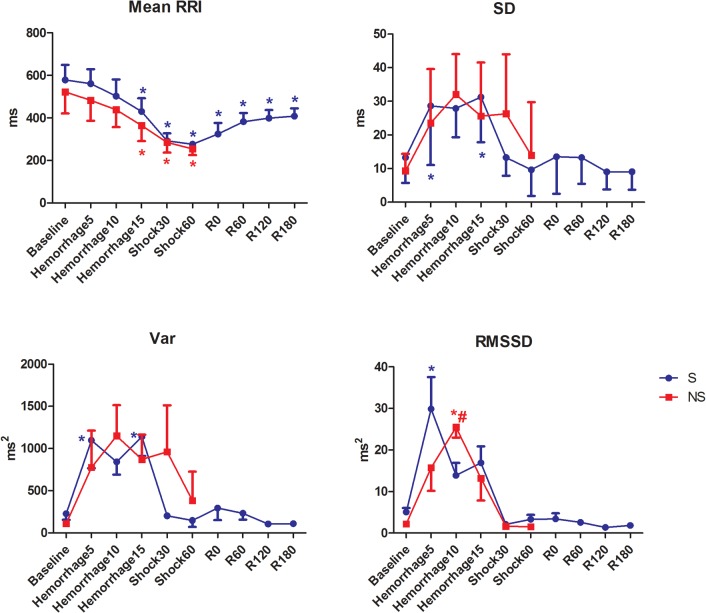
HRV time domain metrics in pigs submitted to acute hemorrhagic shock and fluid resuscitation.S = survivor group. NS = non-survivor group; * = P<0.05 different from baseline; # = p<0.05 NS group different from the S group (t test).